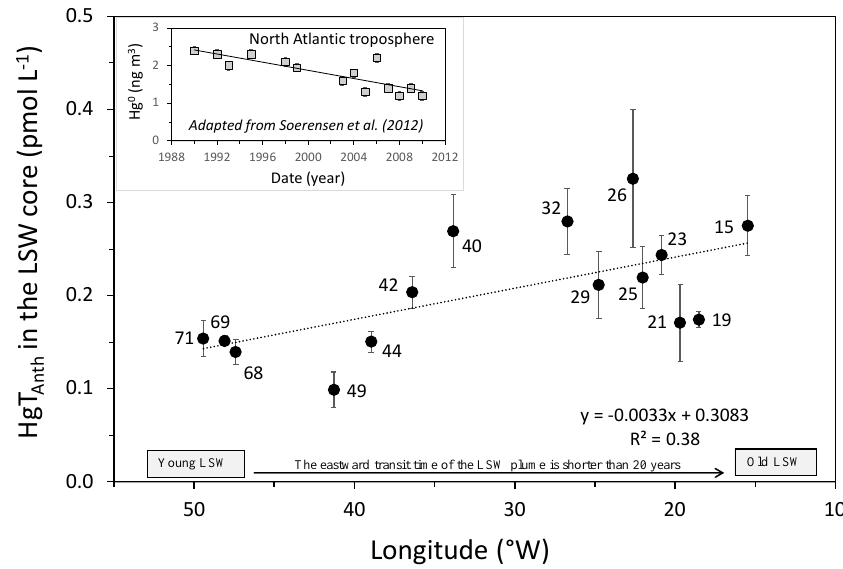
Figure 6. Anthropogenic HgT (HgT Anth ) concentration distribution in the core of the Labrador Sea Water (LSW) ( S = 34 . 9, σ O = 27.74– 27.82, 1200–2000m) between the Labrador Sea and the eastern North Atlantic basin. HgT Anth values were obtained according to the model by Lamborg et al. (2014). Young LSW corresponds to the LSW 2014 ) formed during winter 2013–2014. The insert shows the Hg concentration decrease in the troposphere over the North Atlantic during the last 20 years according to Soerensen et al. (2012). Table 1. Total Hg in unfiltered samples (HgT UNF ) vs. apparent oxygen utilization (AOU) concentrations of each source water type (SWT), calculated according to eOMP (Eq. 1) (see also García-Ibáñez et al., 2018). Corrected HgT UNF is a theoretical HgT concentration for a AOU concentration equal to zero, using the equation from Fig. 5. ENACW 12 : eastern North Atlantic Central Water of 12 ◦ C; SPMW 8 and SPMW 7 : Subpolar Mode Water of the Iceland basin of 7 and 8 ◦ C; IrSPMW: Subpolar Mode Water of the Irminger basin; LSW: Labrador Sea Water; MW: Mediterranean waters; ISOW: Iceland–Scotland Overflow Water; NEADW L : Lower North East Atlantic Deep Water; DSOW: Denmark Strait Overflow Water; PIW: Polar Intermediate Water; and SAIW 6 : Subarctic Intermediate Water of 6 ◦ C. SWT HgT UNF